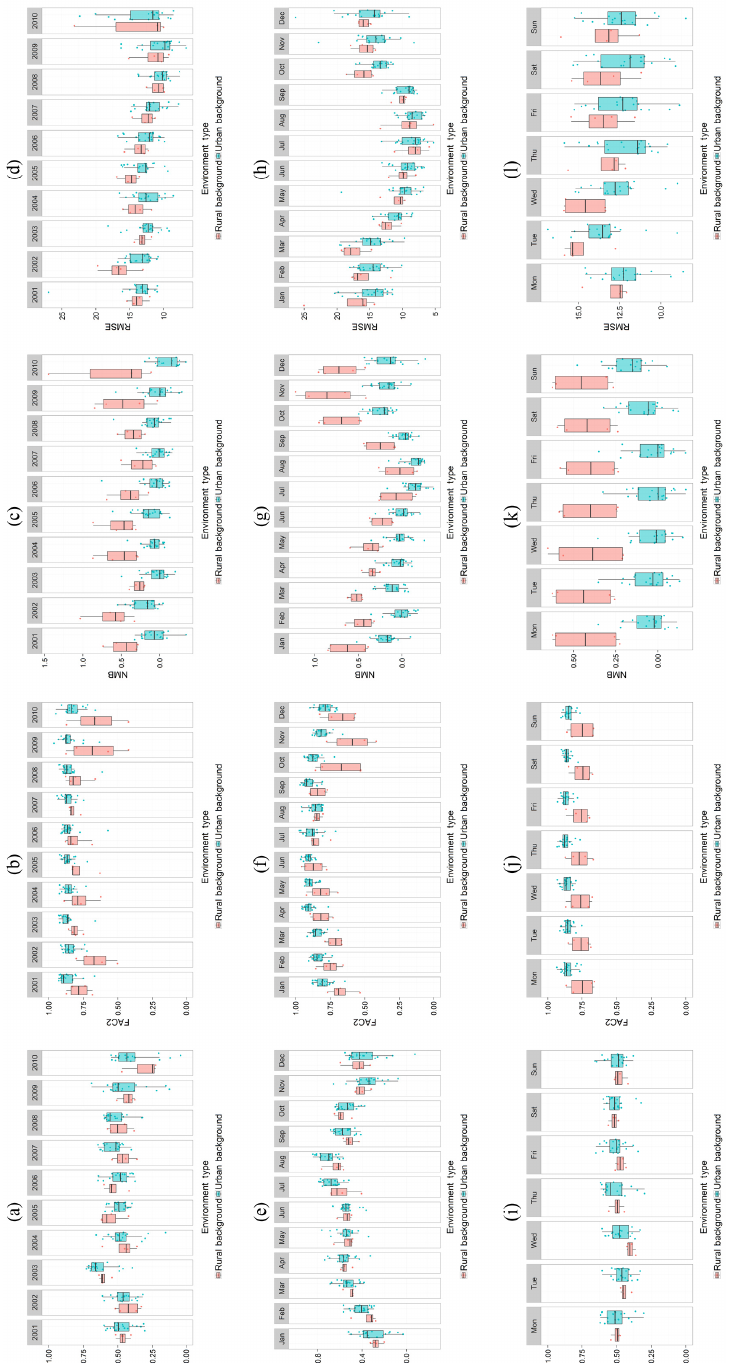
Figure 4. Model–measurement statistics per site for PM 10 daily mean concentrations during 2001–2010, by site type, and by (a–d) year, (e–h) month-of-year, and (i–l) day-of-week. (a) , (e) , and (i) are Pearson’s correlation coefficient ( r) ; (b) , (f) , and (j) are the fraction of data pairs within a factor of 2 (FAC2); (c) , (g) , and (k) are normalized mean bias (NMB); and (d) , (h) , and (l) are the root mean squared error (RMSE) in µgm − 3 . Dots show individual site statistics ( n = 4 and 20 for RB and UB sites, respectively), which are summarized in the superimposed box plot whose shading demarcates the interquartile range (IQR) and whose whiskers extend to the largest and smallest values within 1.58 × IQR from the box